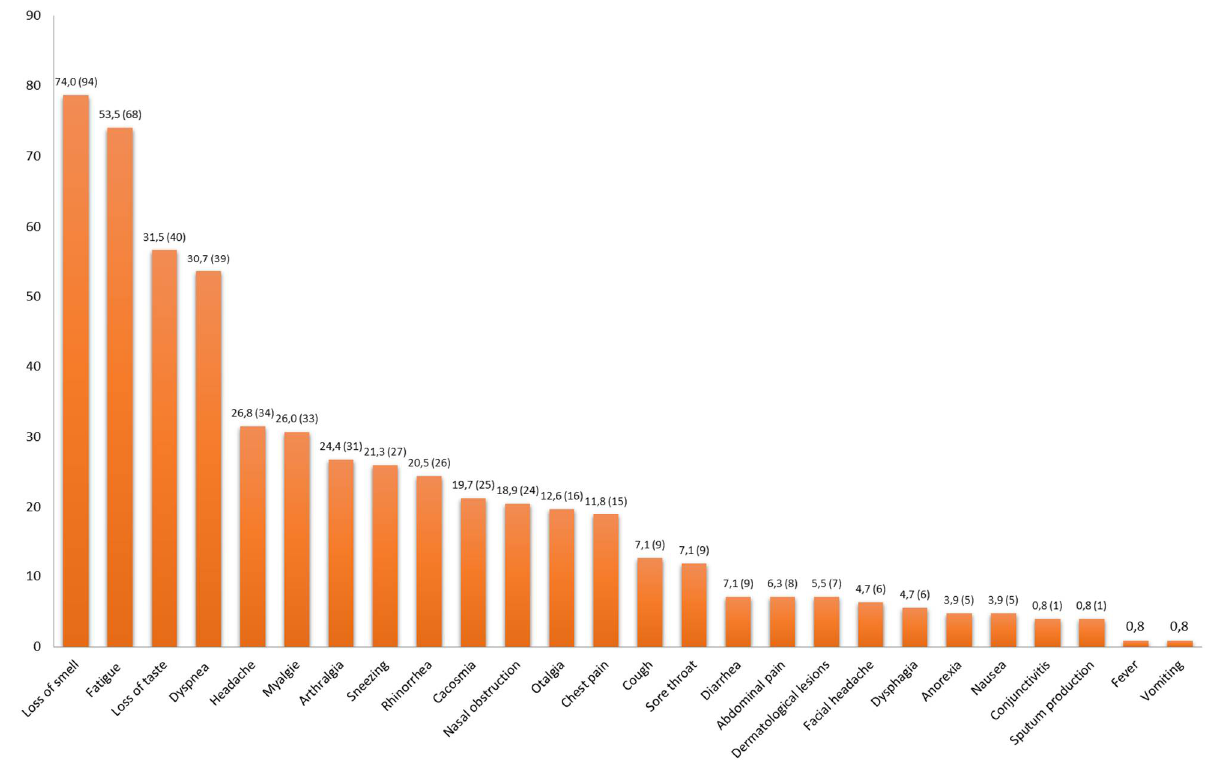
Figure 1. Proportion of persistent symptoms in the persistent symptom group ( n = 127) after SARS-CoV-2 infection. Table 2. COVID-19 patients with persistent symptoms after SARS-CoV-2 infection, Nord Franche-Comte Hospital, France. Persistent Symptoms (Number)